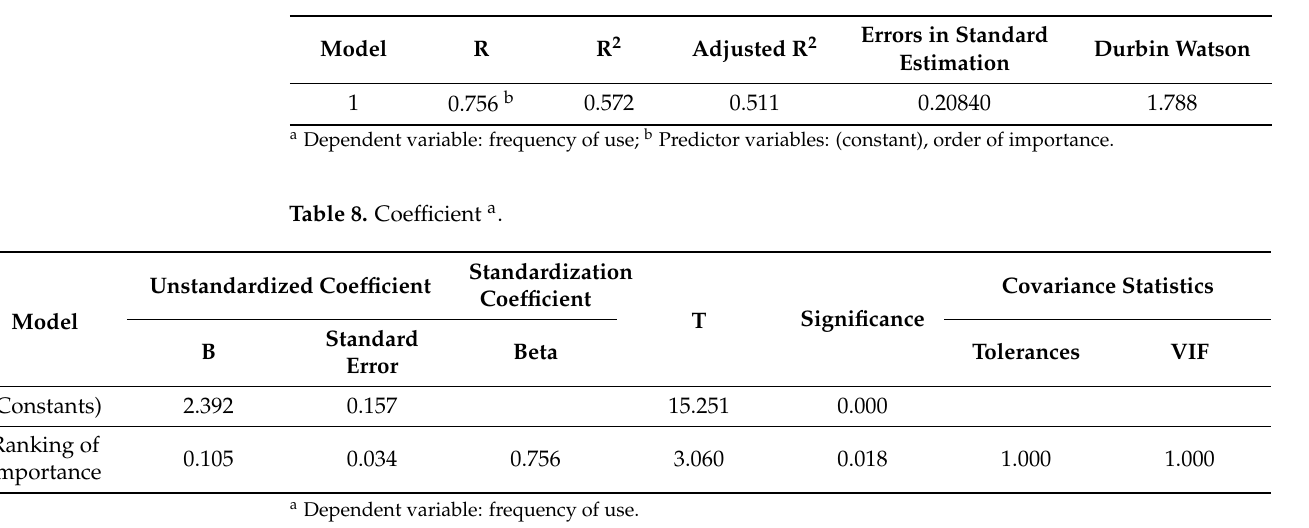
Figure 12. The initial version of the system.